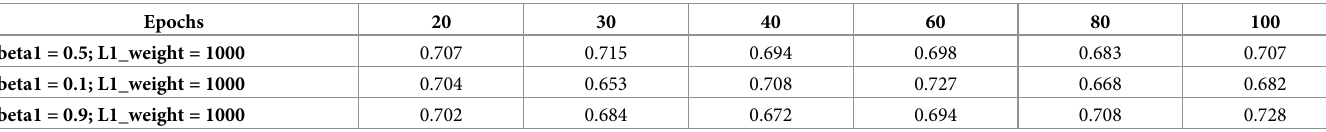
Table 3. Results of grid search for beta1 and L1_weight combinations as well as training epochs in the model validation datasets.